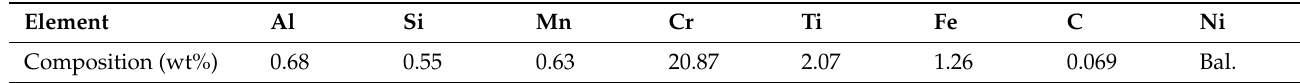
Table 2. Chemical composition of TZM alloy.